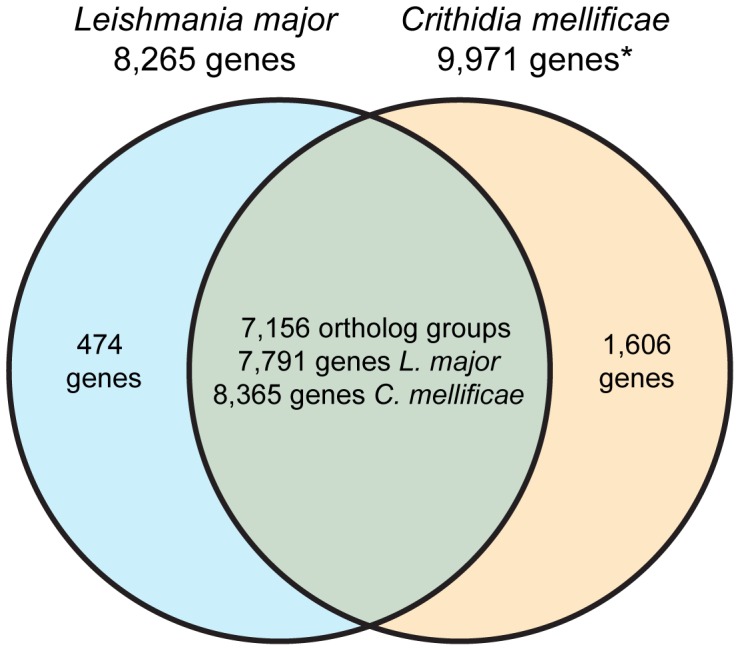
The gene catalogues of Leishmania major and Crithidia mellificae are compared after ortholog analysis by INPARANOID [60].*Truncated genes at contig ends were included in this analysis for a total of 9,971 ORFs. Approximately 17% of these ORFs are incomplete ends of the same presumed gene, resulting in ∼8,300 actual genes (see Results).